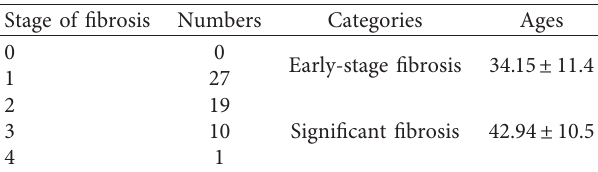
Figure 3: Flowchart of feature selection and texture analysis. Table 1: Distribution of stages of